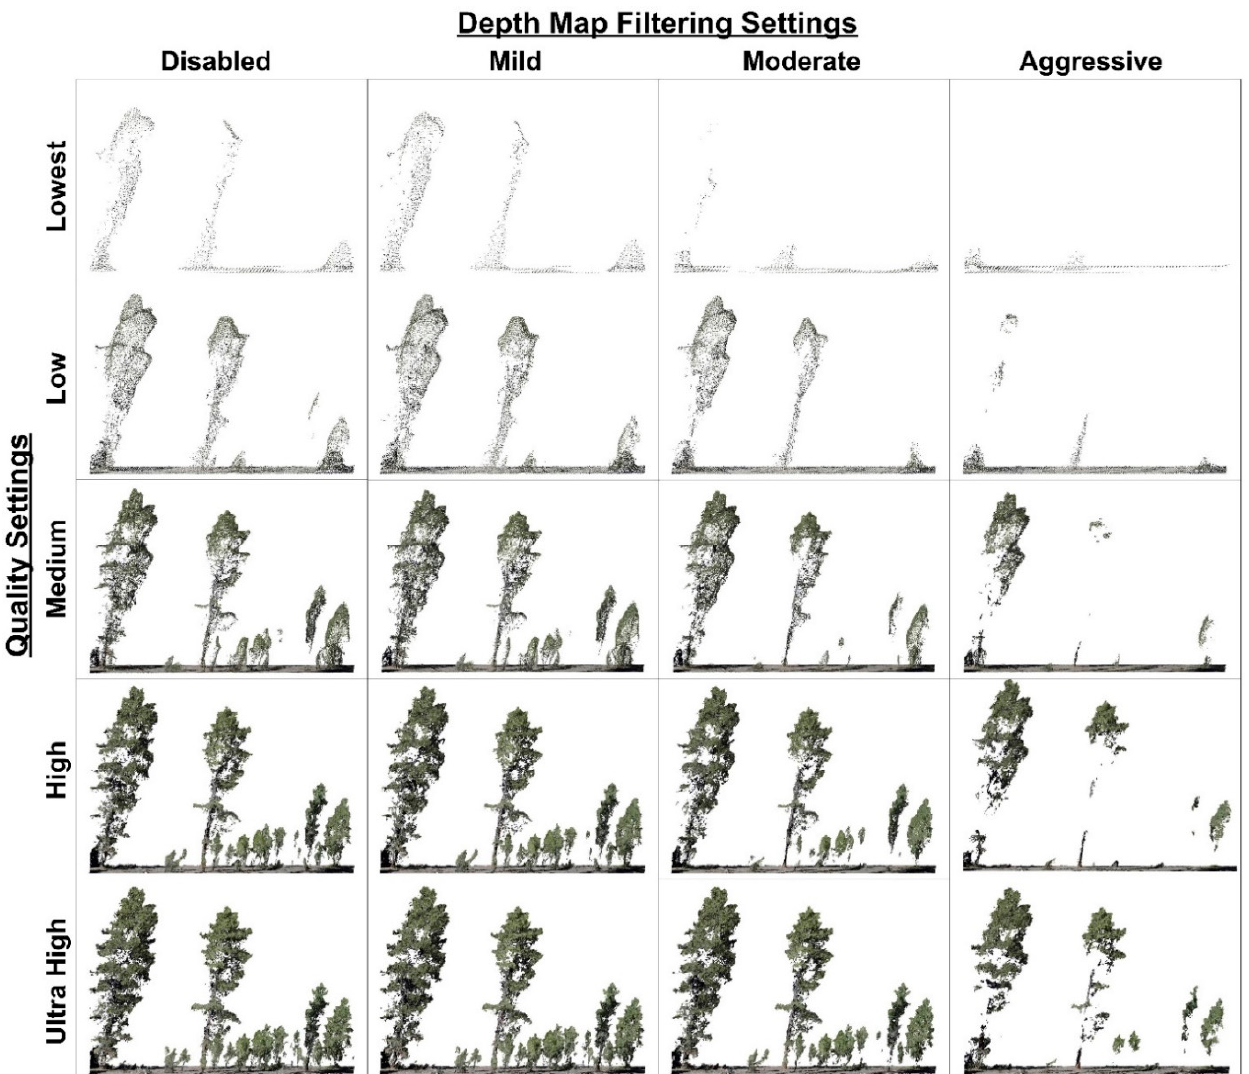
Figure 2. Subsets of filtered UAS-structures from motion (SfM) point clouds (15 m × 30 m) for the 20 combinations of the build dense cloud Quality and depth map filter parameter settings.